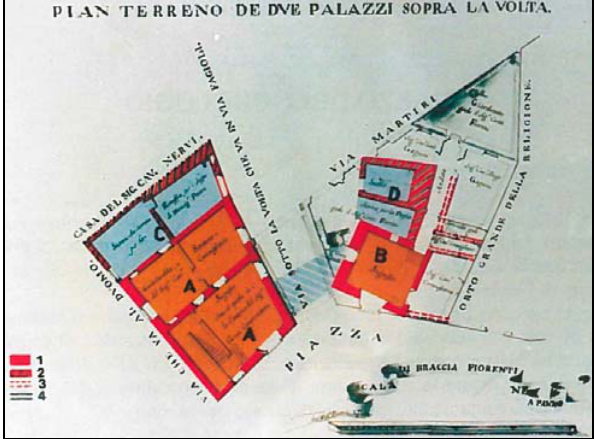
Figure 1 – Scheme of “Palazzo dell’Orologio” before 1754 [Karwacka Codini E.], where different age areas are